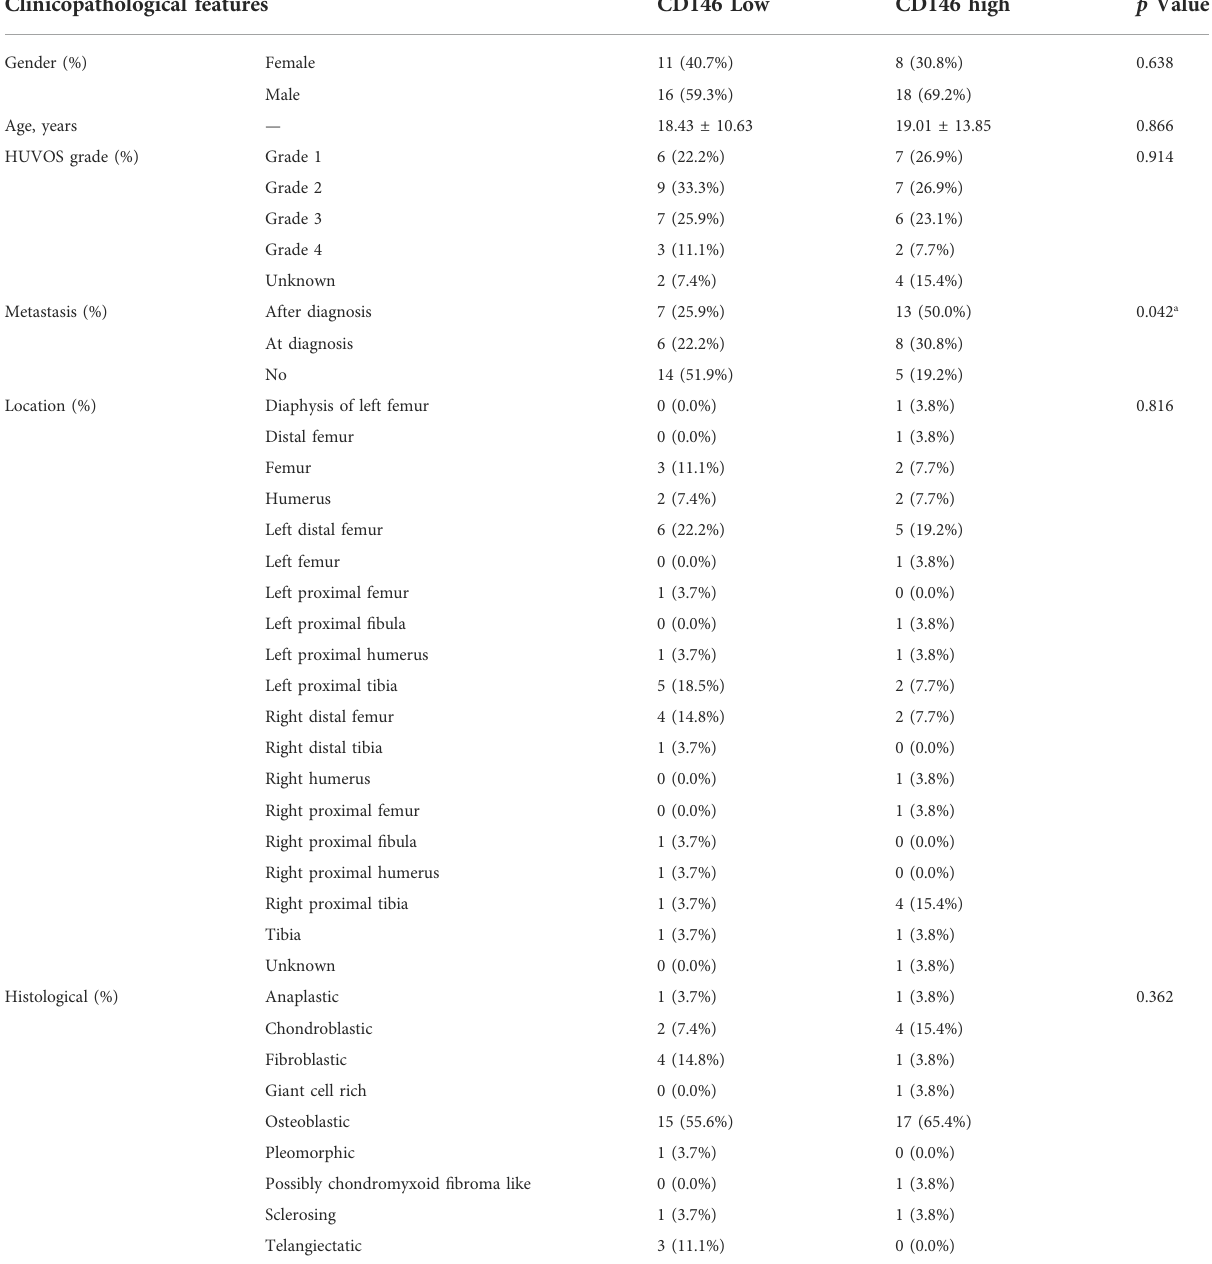
TABLE 3 Clinical features of CD146 low and high groups in GSE21257 cohort. Clinicopathological